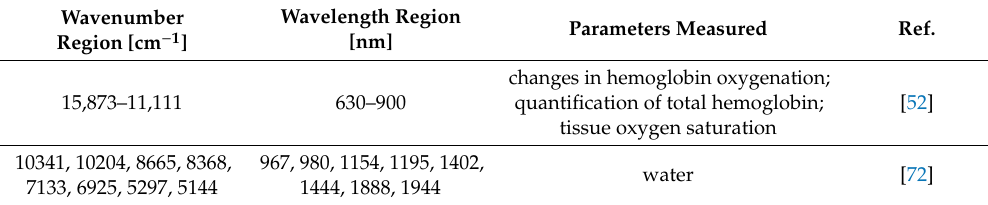
Table 4. Absorption regions that are meaningful for characterizing cancer tissue by NIR spectroscopy. For sake of completeness, listed are wavelength regions extended to Vis